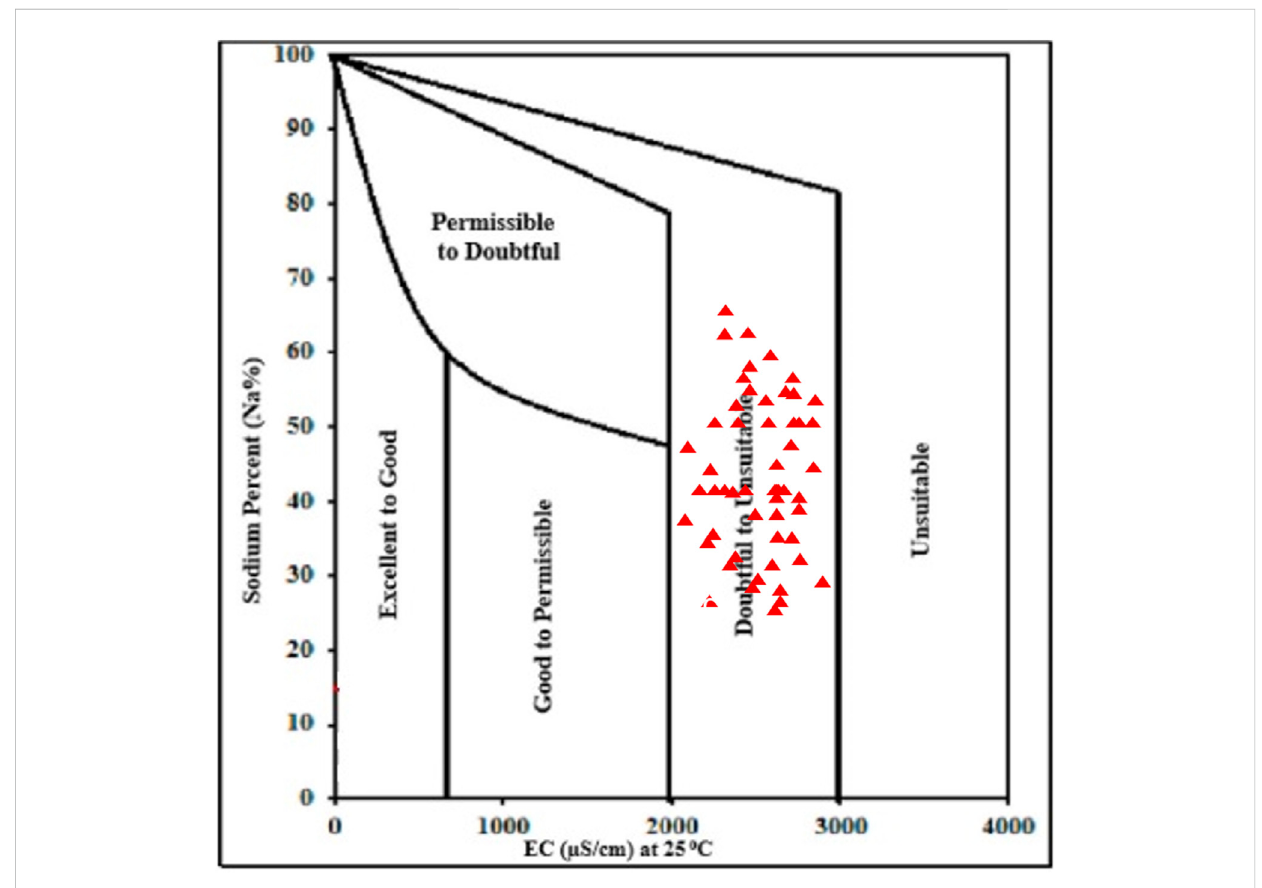
FIGURE 3 Irrigation water classi fi cation based on Wilcox